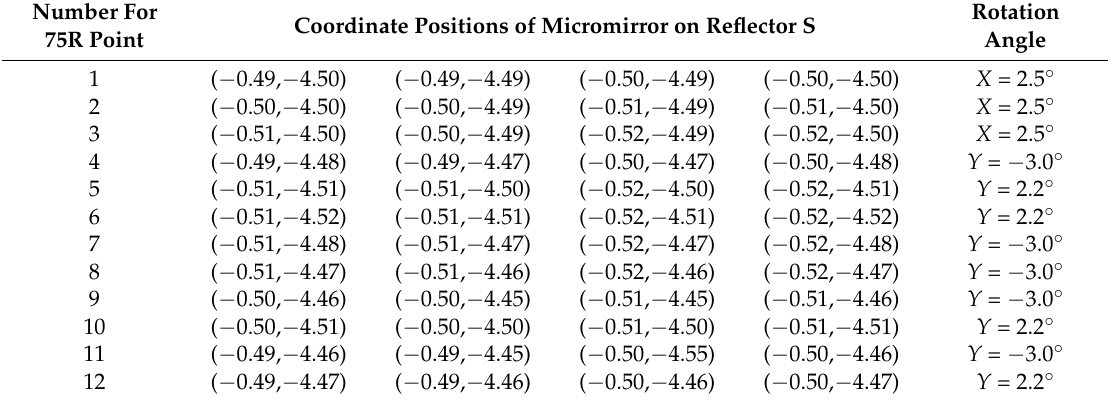
Table 2. Coordinate positions and rotation angles of the 12 micromirrors used for compensation “Point 75R” illumination.